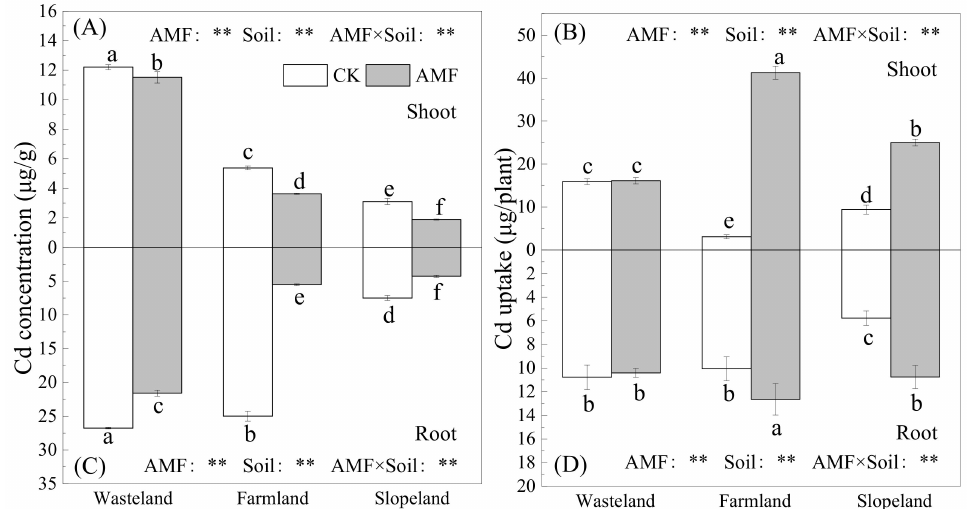
Figure 3. Effects of AMF on cadmium concentration and uptake in maize. ( A ): the shoot Cd concentrations of maize with and without AMF inoculation; ( B ): the shoot Cd uptake of maize with and without AMF inoculation; ( C ): the root Cd concentrations of maize with and without AMF inoculation; ( D ): the root Cd uptake of maize with and without AMF inoculation. The different lowercase letters indicate significant differences among treatments; “**” mean p < 0.01 according to two-way